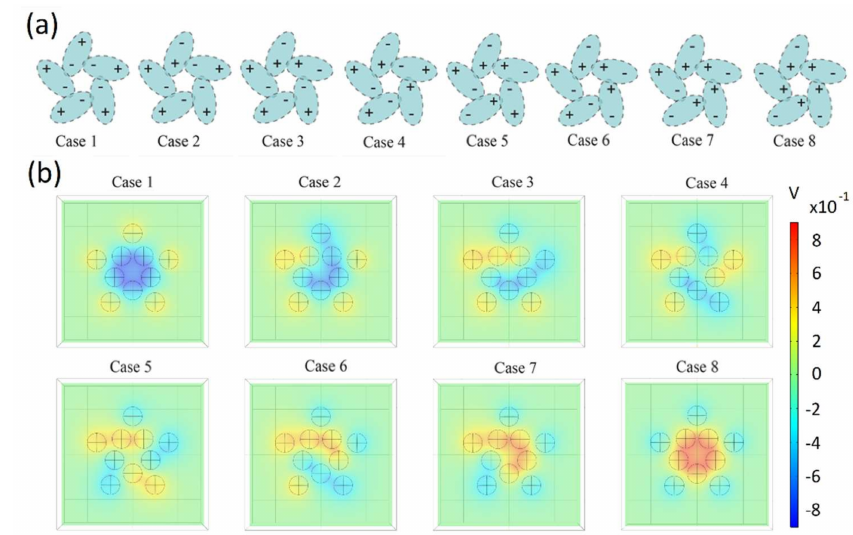
Figure 3. ( a ) Eight di ff erent charge distribution cases on the pentagon-shaped dipole arrangement. ( b ) Simulated results of the corresponding electrostatic potential distributions.